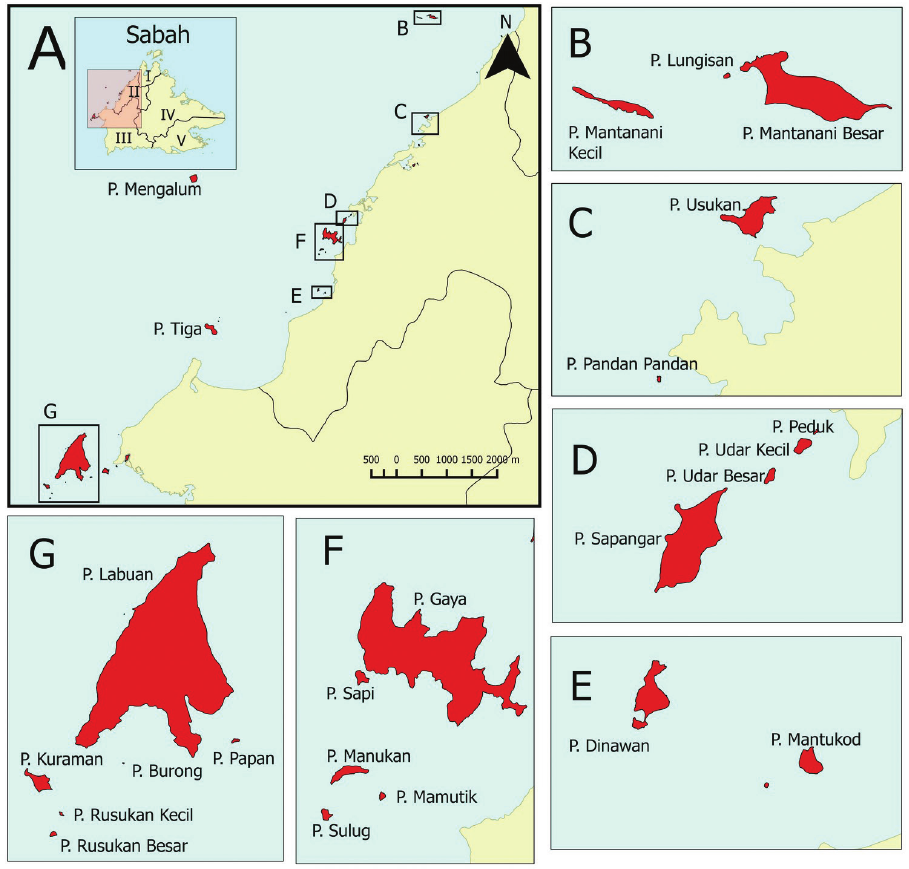
Figure 1. The 24 islands located off the Sabah west coast sampled for this study. A Sabah overview map with five divisions shown, namely (I) Kudat division, (II) West Coast division, (III) Interior division, (IV) Sandakan division, (V) Tawau division; Pulau Mengalum and Pulau Tiga shown in enlarged Sabah west